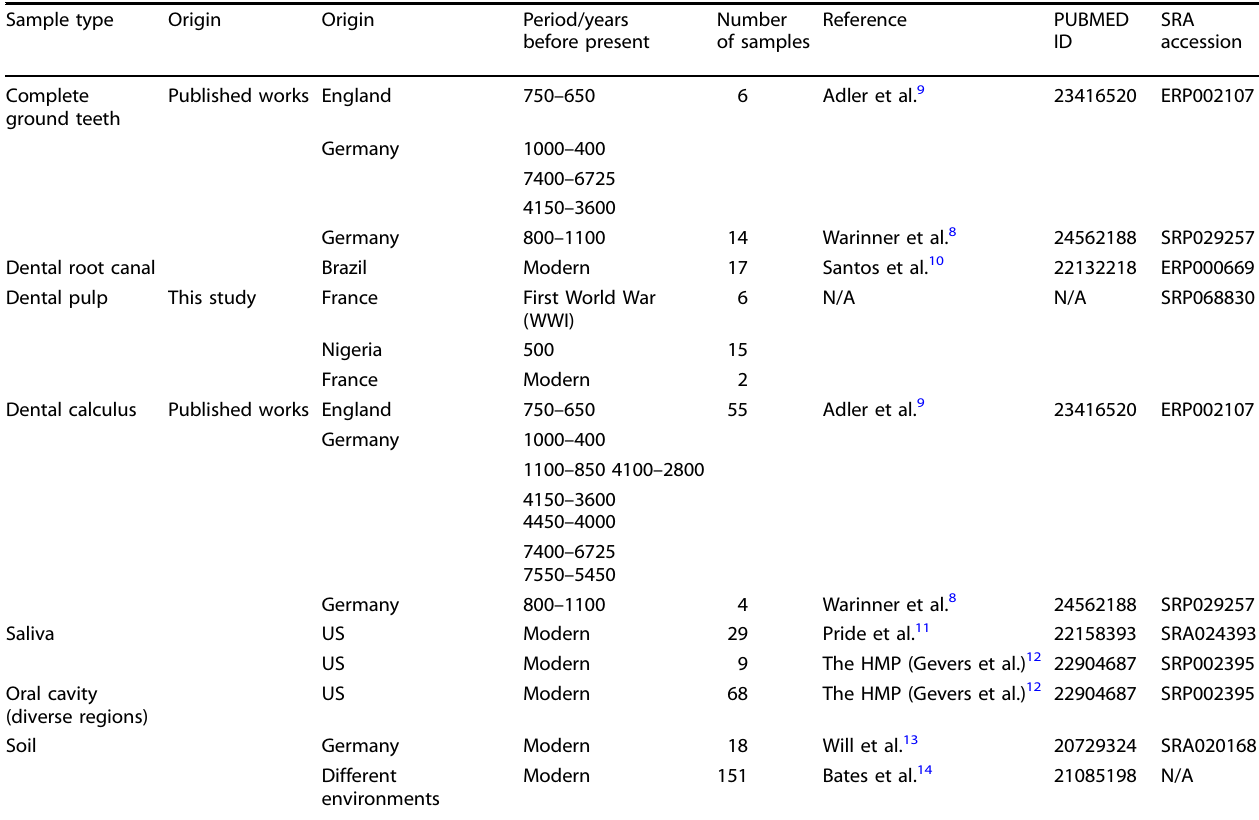
Table 1. Description of the samples and data sets used in this